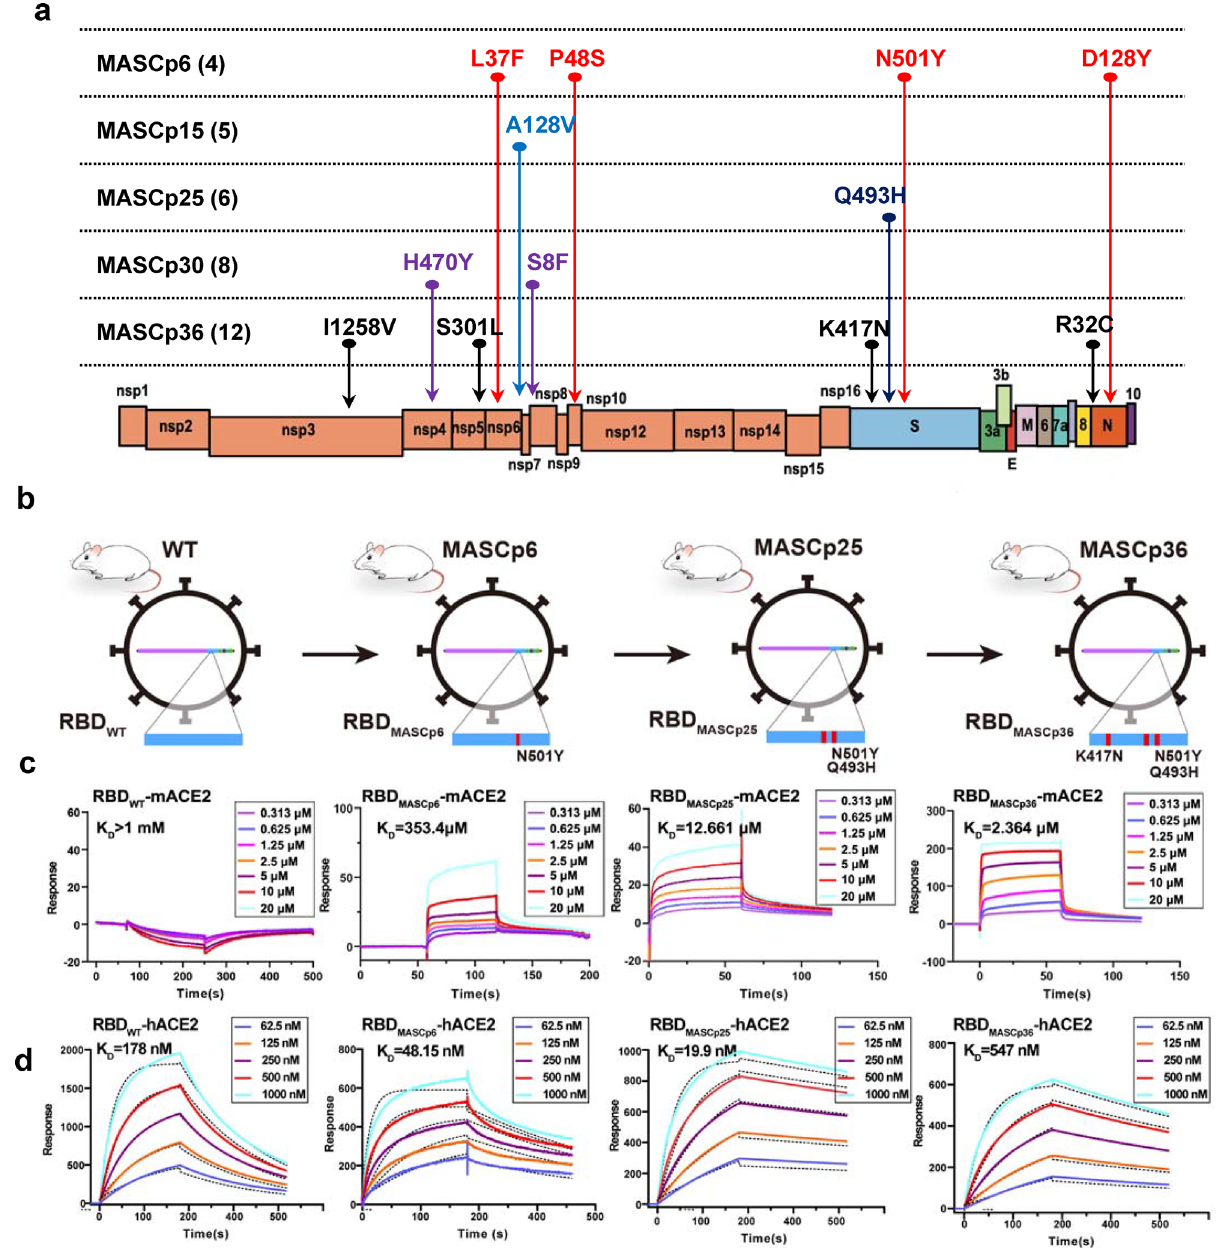
Fig. 8 Adaptive RBD mutations identi fi ed in different mouse-adapted strains. a Schematic diagram of SARS-CoV-2 genome and all the adaptive mutations. b Schematic diagram depicting virus harboring different RBD mutations. The mutation site is marked with a red rectangle. The proportion of N501Y, Q493H, K417N mutations located on the RBD. c , d Binding properties of RBD WT , RBD MASCp6 , RBD MASCp25 , and RBD MASCp36 to mACE2 and hACE2 analyzed using SPR. For both panels, mACE2 was loaded onto the sensor; RBD WT , RBD MASCp6 , RBD MASCp25 , and RBD MASCp36 were injected. Response units were plotted against protein concentrations. The KD values were calculated by BIAcore ® 3000 analysis software (BIAevaluation version